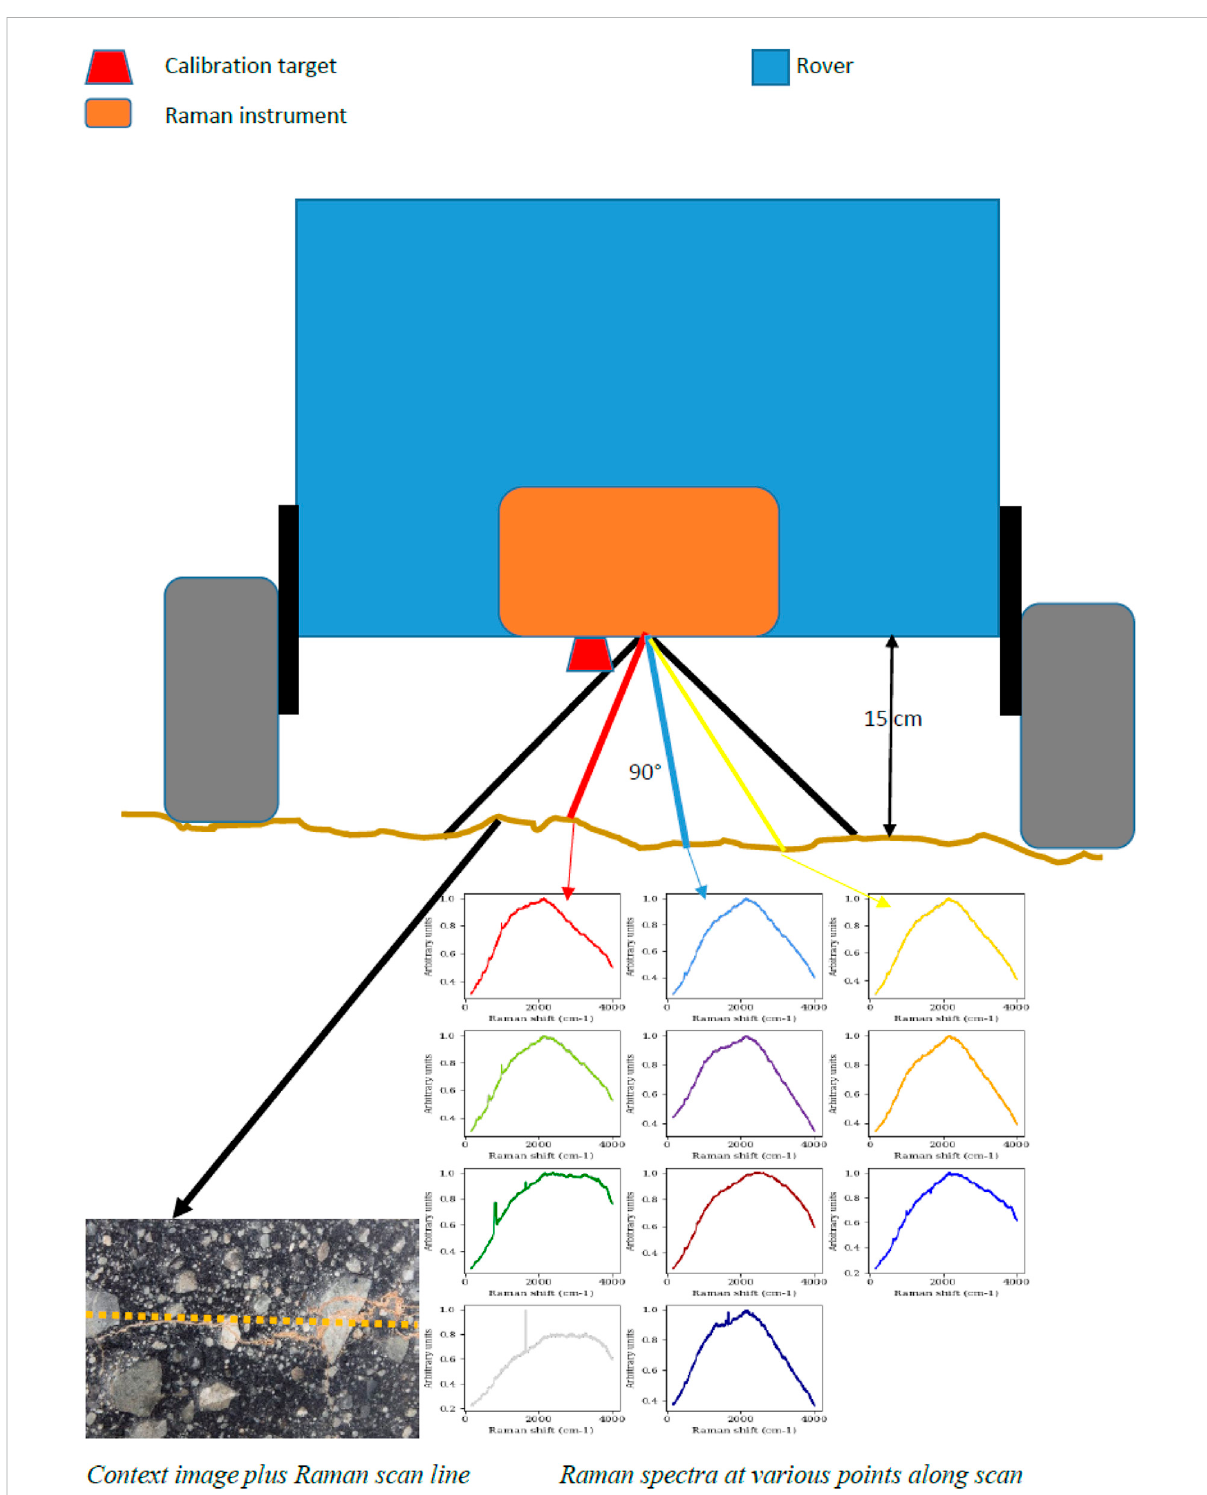
FIGURE 4 Sketchfront viewofaLunaRRamanspectrometer-hostingrovershowingacross-track fi eldofviewoftheRamanspectrometer(±45 ° offnadir) and calibration target located at the edge of the fi eld of view of the Raman spectrometer; not to